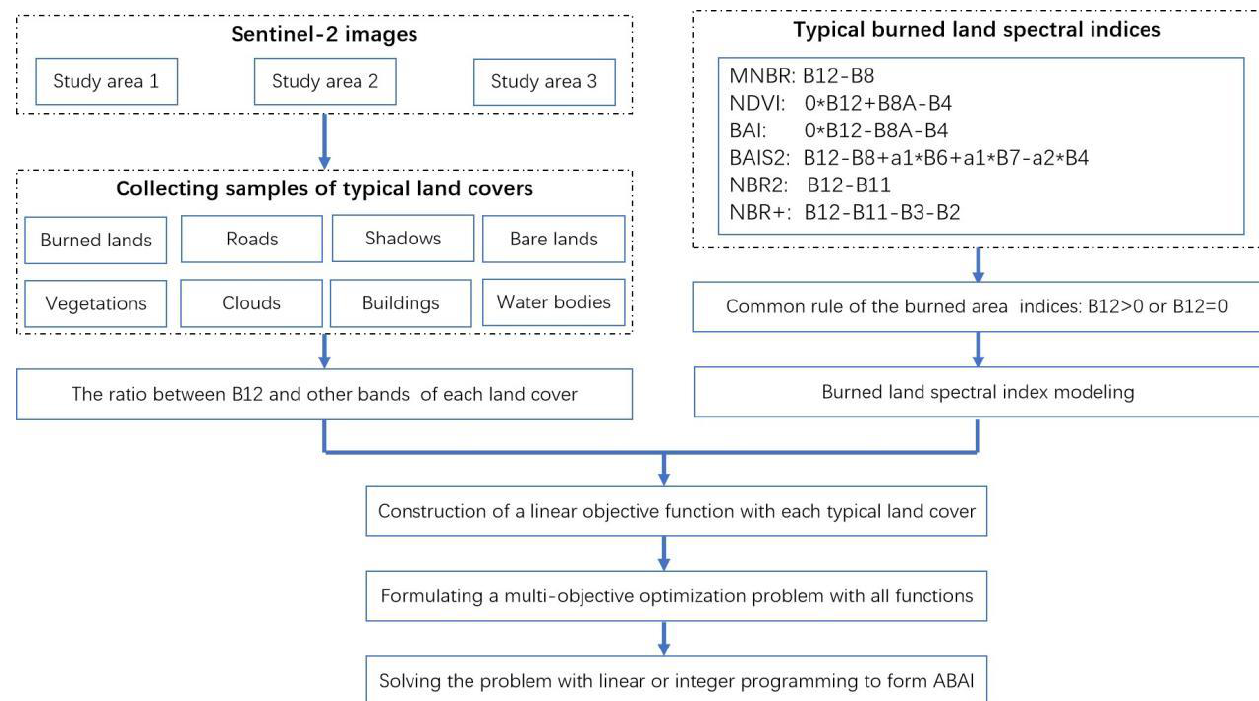
Figure 2. The framework of the ABAI construction.